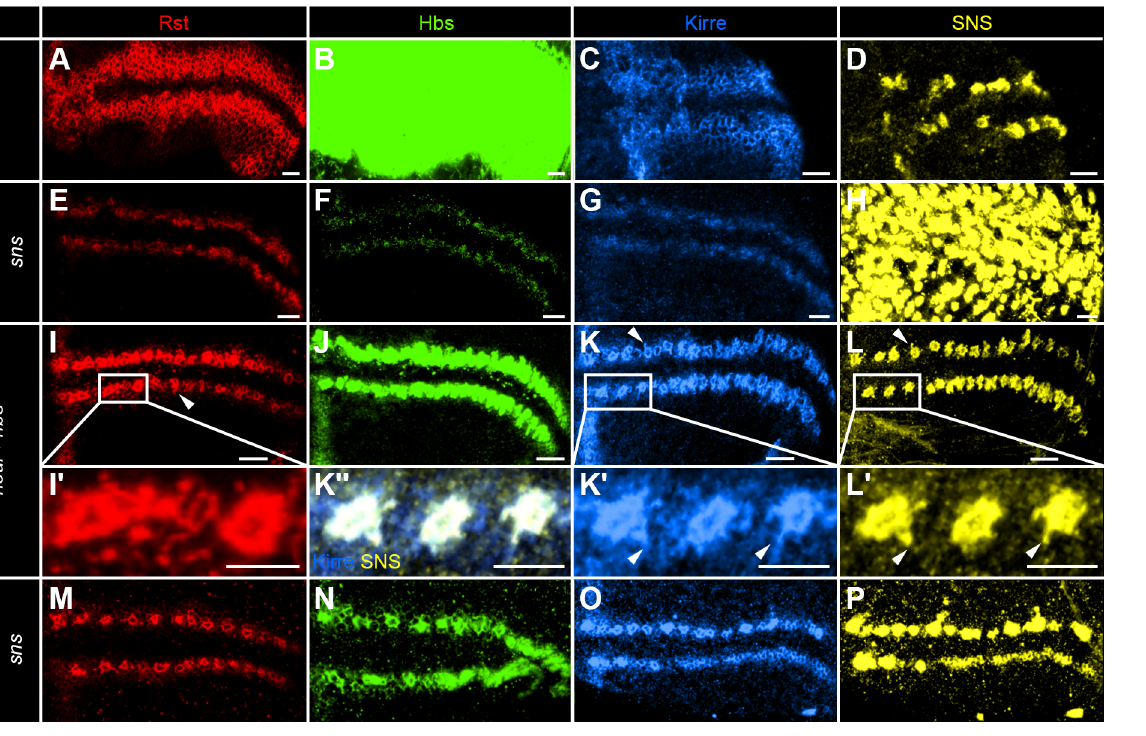
Fig 5. The Nephrin-like proteins Hbs and SNS affect other IRM-proteins asymmetrically and induce filopodial extensions. (A-L) Projection view of IRM immunoreactivity in late third instar larvae. Rst is shown in red (A, E, I and M), Hbs in green (B, F, J and N), Kirre in blue (C, G, K and O) and SNS in yellow (D, H, L and P). (A-D) Misexpression of hbs using MZ1369-GAL4 leads to a significant enlargement of Rst (A) and Kirre (B) immunoreactivity positive areas. Specific enrichment of immunoreactivity around the SOPs is lost. Hbs (C) is ubiquitously located in all membranes. SNS (D) staining shows that the SOPs have lost their regular pattern already in this developmental stage. (E-H) Ubiquitous misexpression of sns via MZ1369-GAL4 leads to reduced staining of Rst (E), Hbs (F) and Kirre (G). SNS (H) staining shows patched expression. (I-L) Overexpression of hbs via neur-GAL4 leads to strongly Rst stained membranes in contact with the SOPs (I). Membranes not in contact to the SOPs show reduced staining. This is also evident in an enlargement of the Rst staining (I ’ ). (J) Hbs staining can be found in the entire SOPs without profound apical basal polarity. (K) Kirre is similar to Rst enriched at the membranes in contact to the SOPs. Hardly any staining can be found in other membranes of the adhesive belt. (L) Cellular localization of SNS is only mildly affected by the hbs misexpression as the protein is mainly, but not exclusively localized at the SOP membrane. Additionally, filopodial outgrowths are frequently observed in this genotype as marked with arrowheads in (I), (K) and (L) and in the enlargements (K ’ ) and (L ’ ). (M-P) Overexpression of sns using neur-GAL4 leads to strongly enriched staining of Rst (M), Hbs (N) and Kirre (O) around the SOPs. (P) SNS can be found along all membranes of the SOPs due to the overexpression. Similar to hbs overexpression are filopodial outgrowth frequently observed. Scale bars correspond to 10 μ m in all